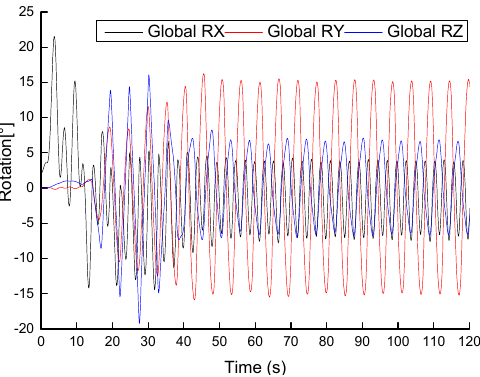
Figure 7. The movement duration of the device in the RX, RY, and RZ directions under the second working condition.